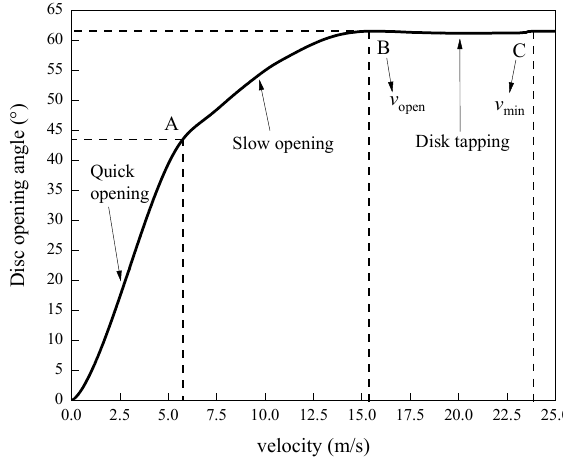
Figure 10. Relation between disc opening angle and molten salt inlet velocity.